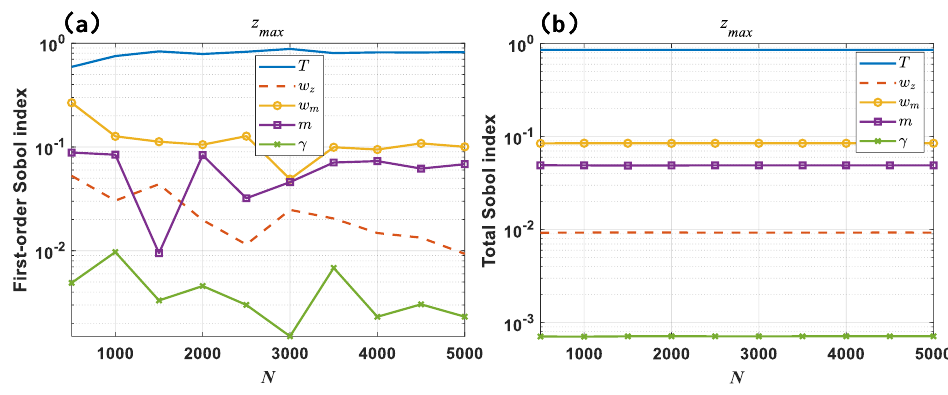
Figure 8. ( a ) Five atmospheric parameters’ first-order Sobol index convergence lines for the max- imum height of infrasound propagation z max ; ( b ) Five atmospheric parameters’ total Sobol index convergence lines for the maximum height of infrasound propagation z max (the blue, dark red, yellow, purple, and light green curves indicate temperature T , zonal wind w z , meridional wind w m , mean atmospheric molar mass m , and specific heat ratio γ ,